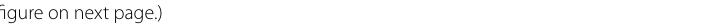
figure on next Fig. 2 FGF21 deficiency enhanced DOCA‑salt‑induced hypertensive renal damage in mice. Eight‑week‑old male FGF21 wild type (WT) and FGF21 knockout (KO) mice based on C57BL/6J were treated with DOCA‑salt or sham operation as controls. a Serum FGF21 levels in each group were determined by ELISA. b Changes in systolic blood pressure measured by a tail‑cuff within 8 days at various time points. c and d Urinary albumin levels and urinary albumin/creatinine ratio were monitored at 8 days in various group mice. e and f Representative images of Hematoxylin–eosin staining and Masson’s trichrome staining in kidney sections harvested at 8d post‑DOCA‑salt treatment. g Quantification of tubulointerstitial injury region from the Hematoxylin–eosin stained images using Image J software. h Quantification of fibrotic degree in tubulointerstitium from the Masson’s trichrome stained images using Image‑Pro plus 6.0 software. The values are expressed as the mean **P < 0.01 versus the WT control group; # P < 0.05 versus the FGF21KO control group; & P < 0.05 versus the WT‑DOCA group. Scale bar: 100